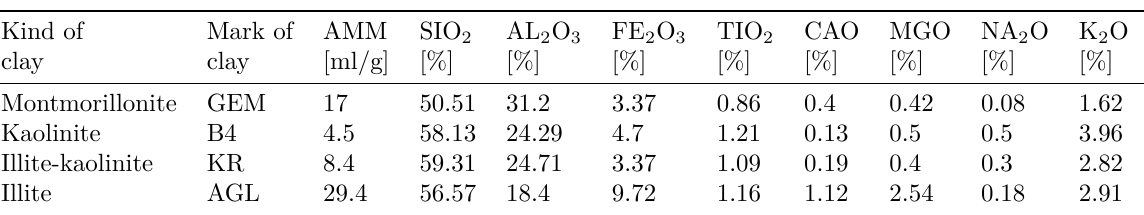
Table 1. Chemical composition of used clays.